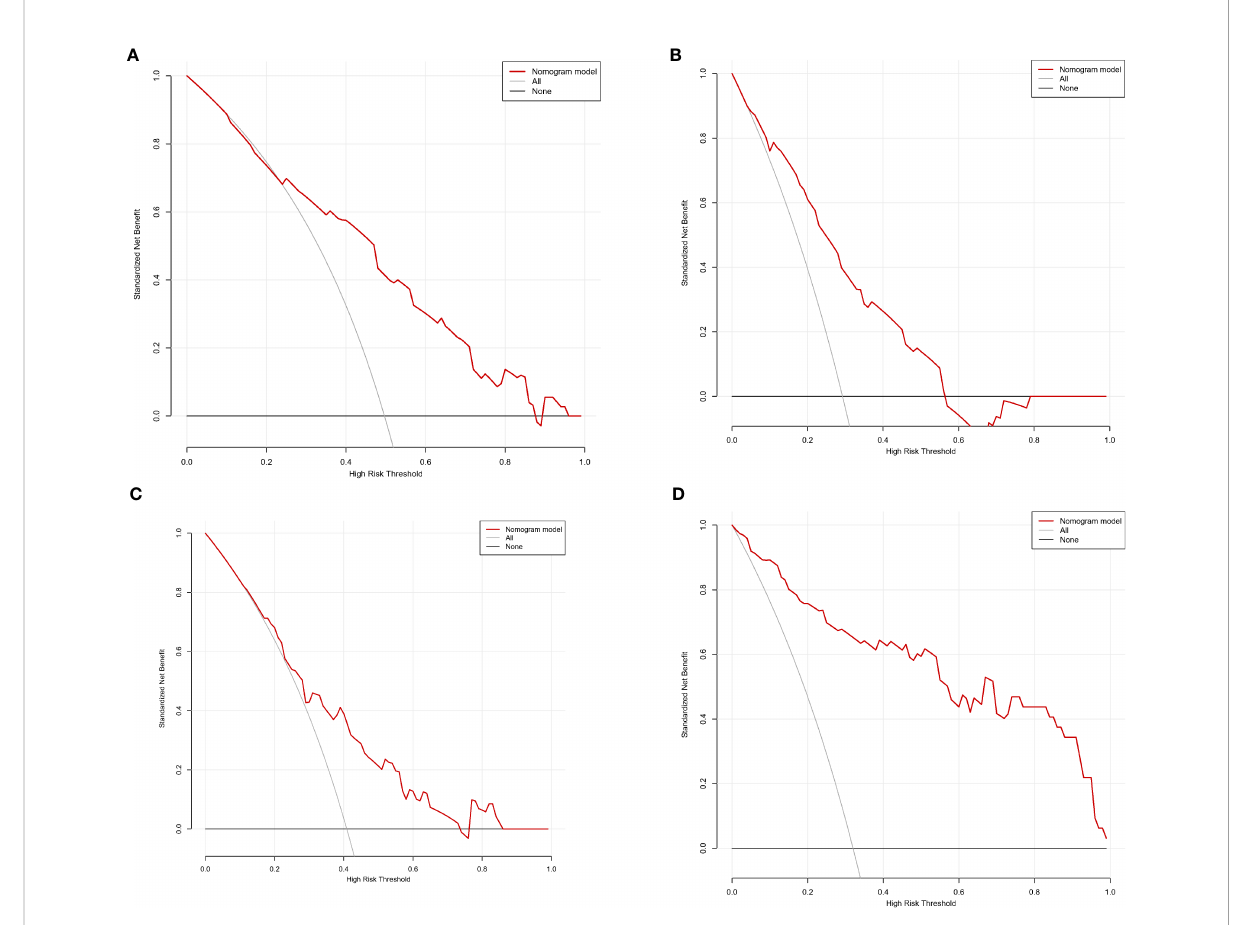
TABLE 6 Metastasis risk strati fi cation of patients with papillary thyroid carcinoma (PTC) based on proportion of cohort. Ipsilateral CLNM Contralateral CLNM Nomogram Proportion Score Risk Proportion Score Risk Proportion Score Risk of 1~4 Risk of >5 Low risk 34% <50 Moderated risk 34% High risk 32% >96 >60% 29.30%